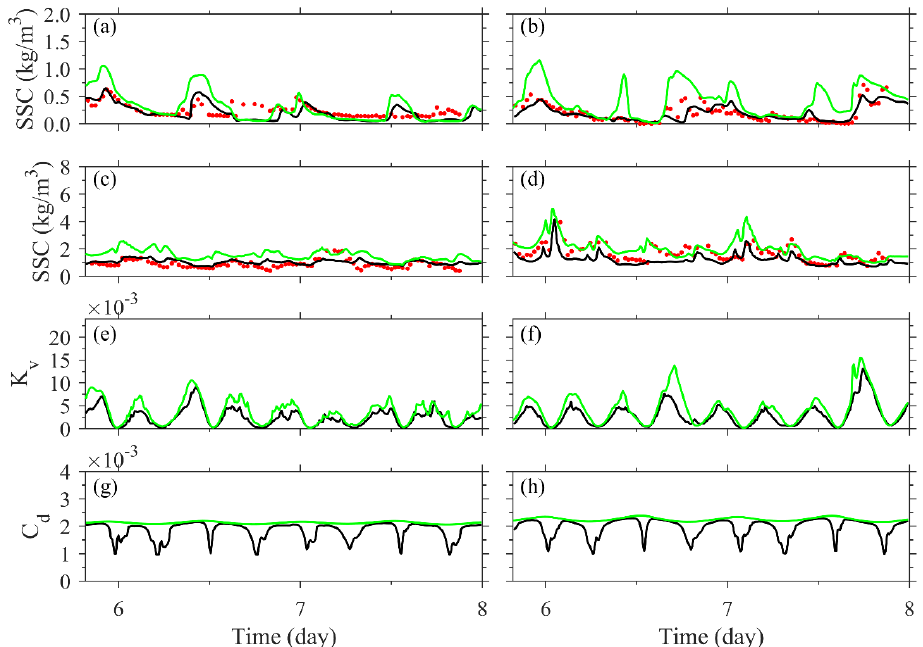
Figure 15. Temporal variation in surface SSC ( a , b ), bottom SSC ( c , d ), vertically averaged eddy diffusivity ( K v ) ( e , f ) and bottom drag coefficient ( C d ) ( g , h ) at measured sites A (left panel) and B (right panel). Black line: with SSC stratification; green line: without SSC stratification; red dots: observed SSC.